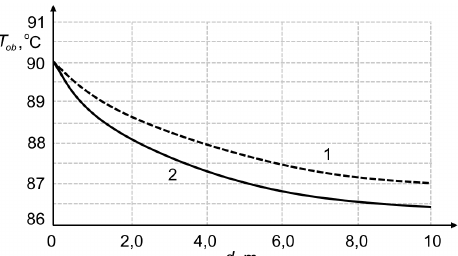
Figure 1. The influence of distance to the temperature measurement for the thermal imaging cameras without taking into account correc- tion of the impact of the atmosphere on the measurement: (1) LW, 8–12µm and (2) SW, 2–5µm – an example (IR-Book, 2000).